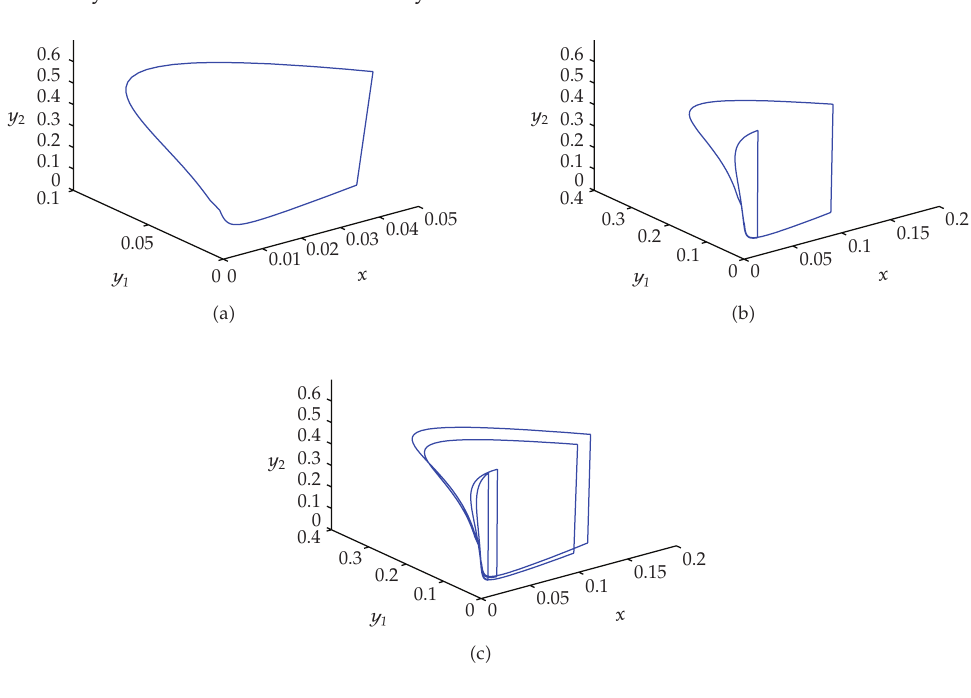
Figure 3: Period doubling cascade: (cid:2) a (cid:3) phase portrait of T -periodic solution for T (cid:6) 12 . 8; (cid:2) b (cid:3) phase portrait of 2 T -periodic solution for T (cid:6) 13 . 5; (cid:2) c (cid:3) phase portrait of 4 T for T (cid:6) 13 . 8.